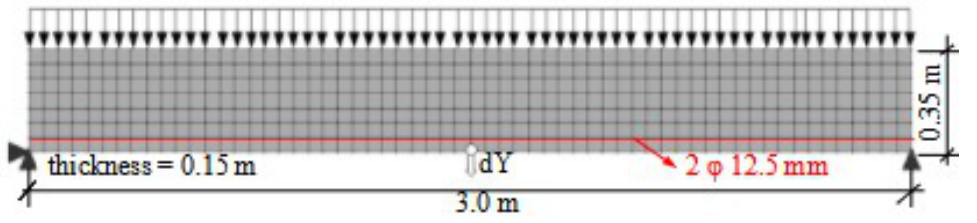
Figure 14. Reinforced concrete beam - geometry and mesh.